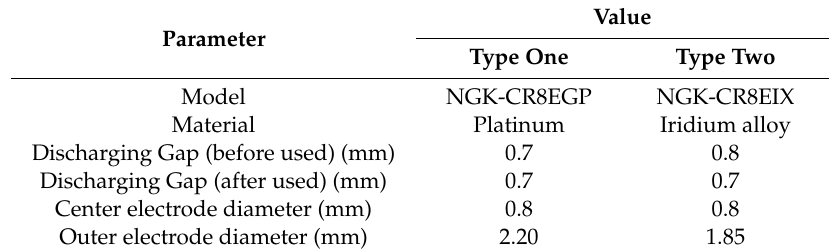
Figure 2. The setup of non-thermal plasma (NTP) system.